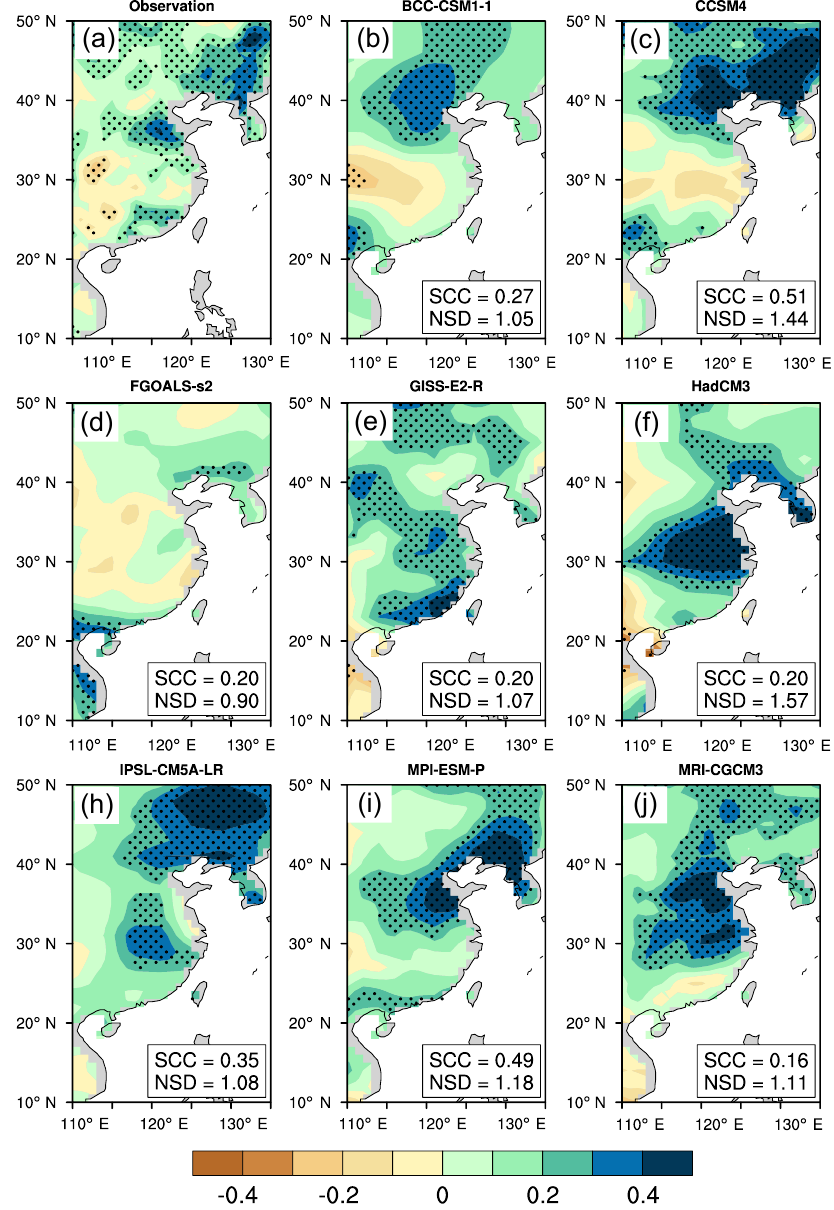
Figure 4. Distribution of the correlation coefficients between the EASM strength and summer precipitation over East Asia in (a) observations (1948–2000AD) and (b–j) PMIP3 historical experiments (1901–2000AD), with spatial correlation coefficients (SCCs) and normalized standard deviations (NSDs) between models and observations shown in bottom right corner. The observed EASM–precipitation relationship is calculated with NCEP/NCAR reanalysis (Kalnay et al., 1996) and the Climate Research Unit TS3.22 monthly dataset (Harris et al., 2014). Areas passing the 95% significance test are